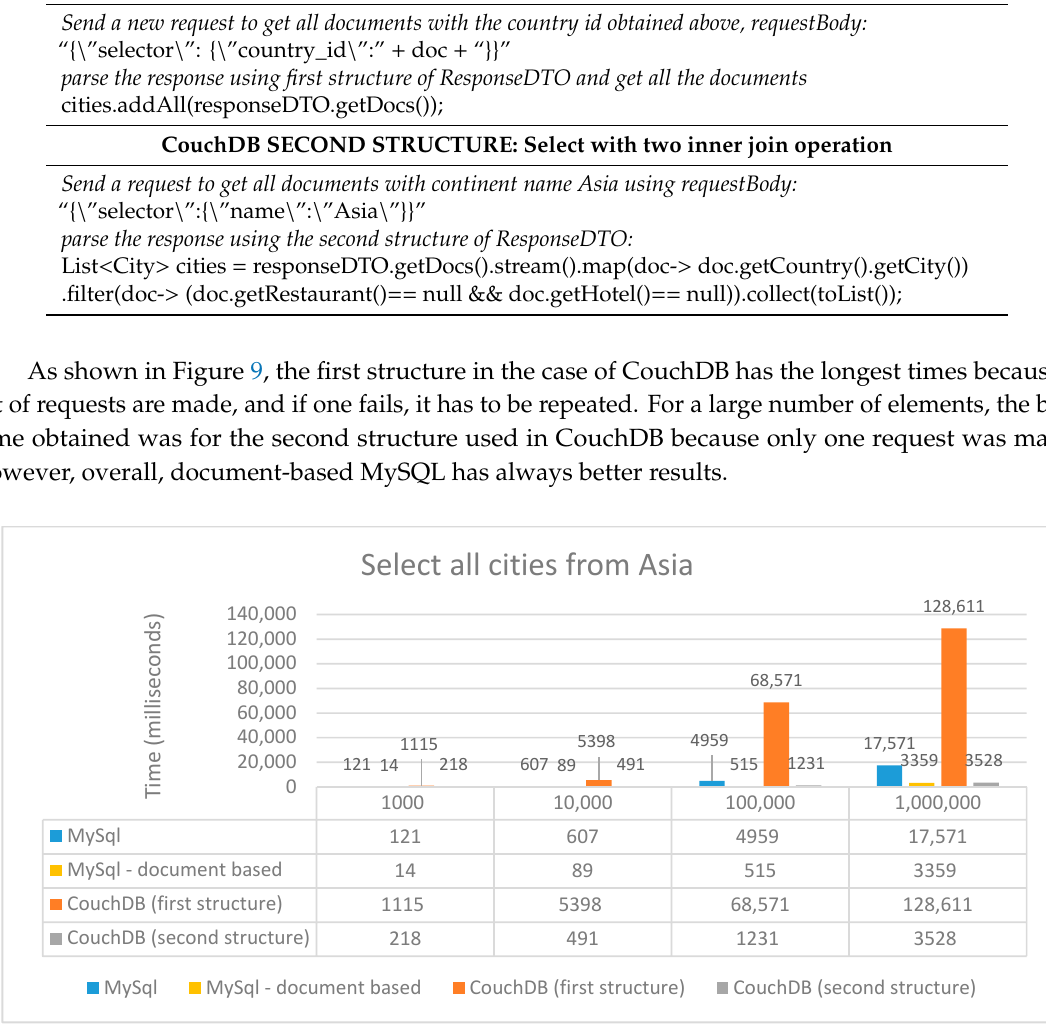
Figure 9. Performance Time (ms) for select with two inner joins.